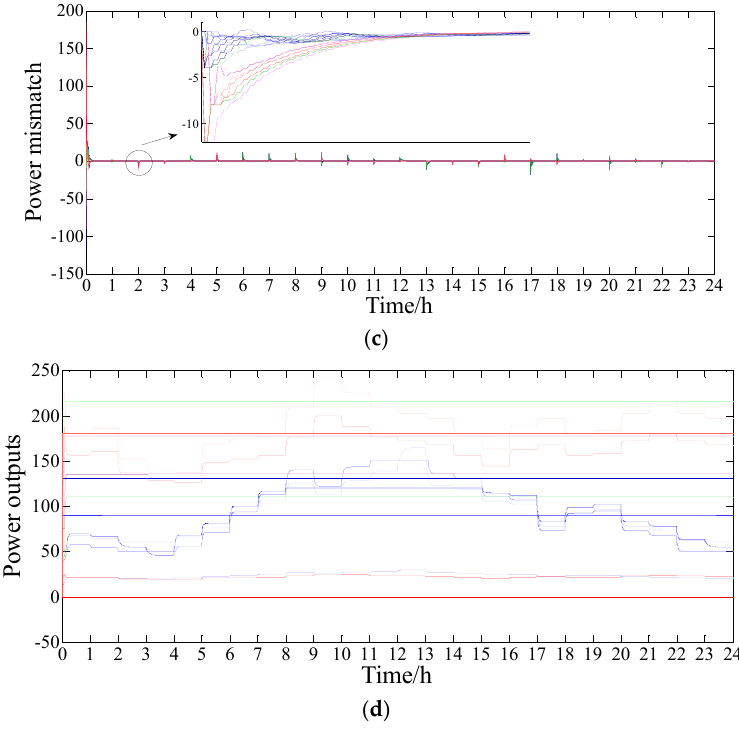
Figure 6. Case study 2, time ‐ varying demand: ( a ) electrical and heat power load demands; ( b ) estimated electrical and heat incremental cost; ( c ) estimated electrical and heat power mismatch; and ( d ) electrical and heat power outputs.